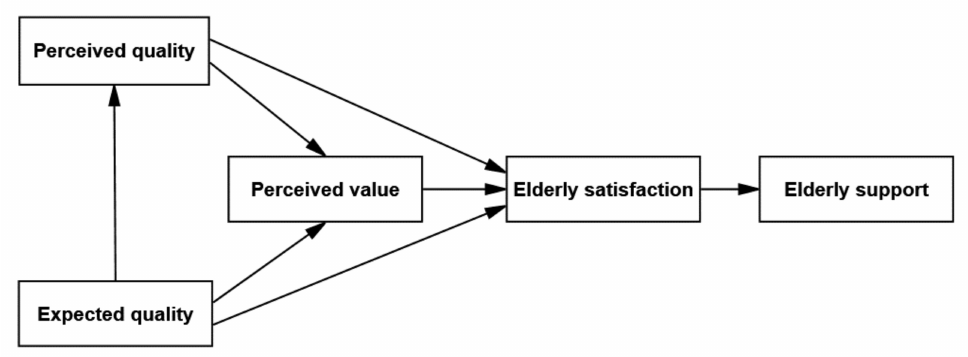
Figure 2. Nursing service elderly satisfaction model.